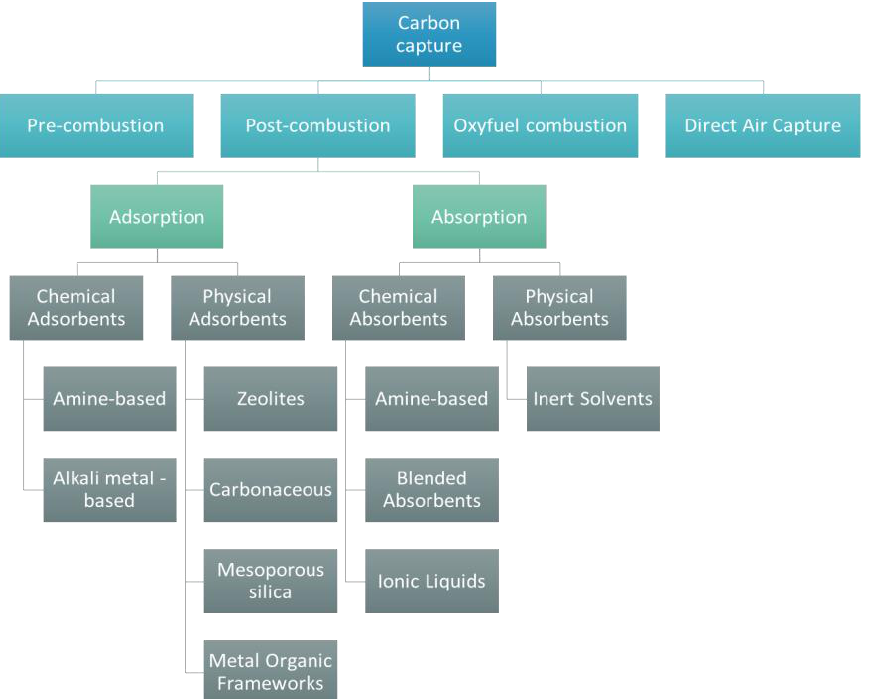
Figure 1. Summary of the adsorbents and the absorbents utilized in post-combustion carbon cap- ture.